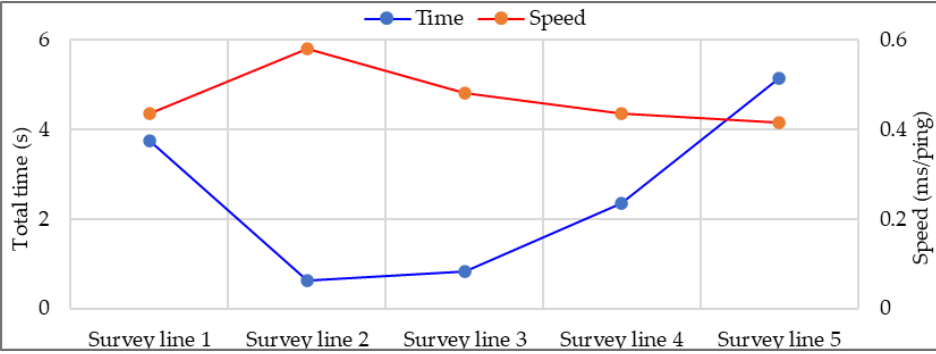
Figure 17. Total time spent on each survey line and the corresponding bottom tracking